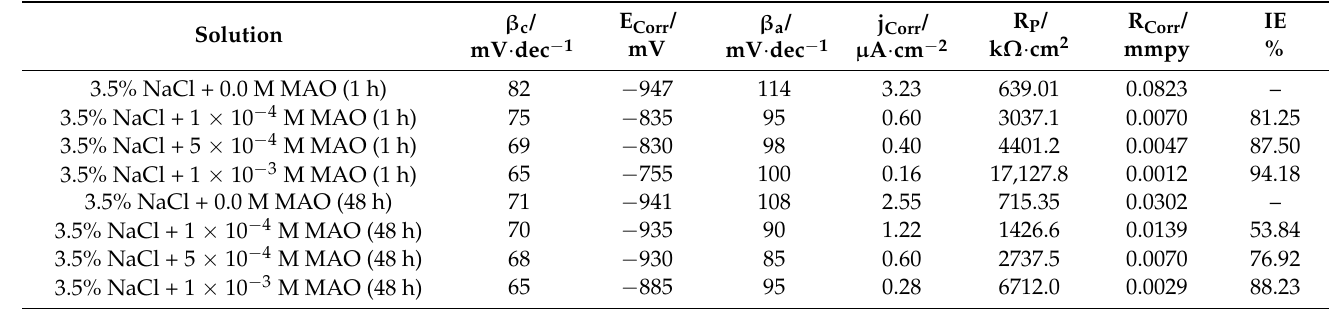
Figure 3. PCP curves of iron after 48 h in ( a ) 3.5% NaCl without and with ( b ) 5 × 10 − 5 M MAO, ( c ) 1 × 10 − 4 M MAO, and ( d ) 5 × 10 − 5 M MAO present, respectively. Table 1. PCP data for iron in the different test solutions.